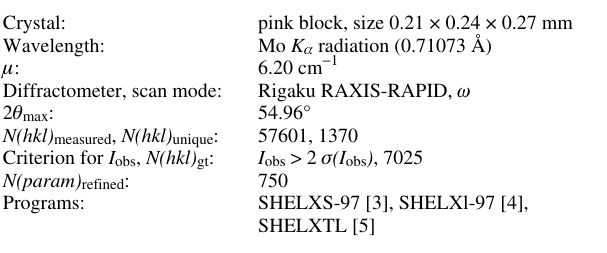
Table 1. Data collection and handling.